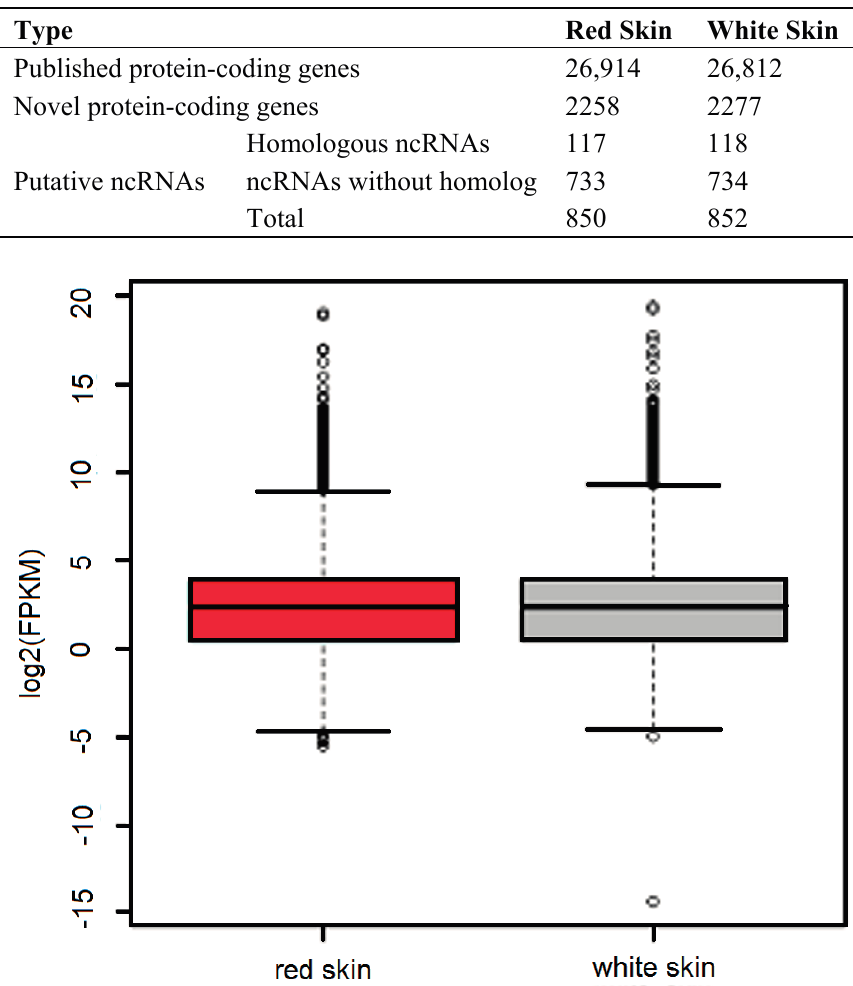
Table 2. The transcribed loci in red skin and white skin.